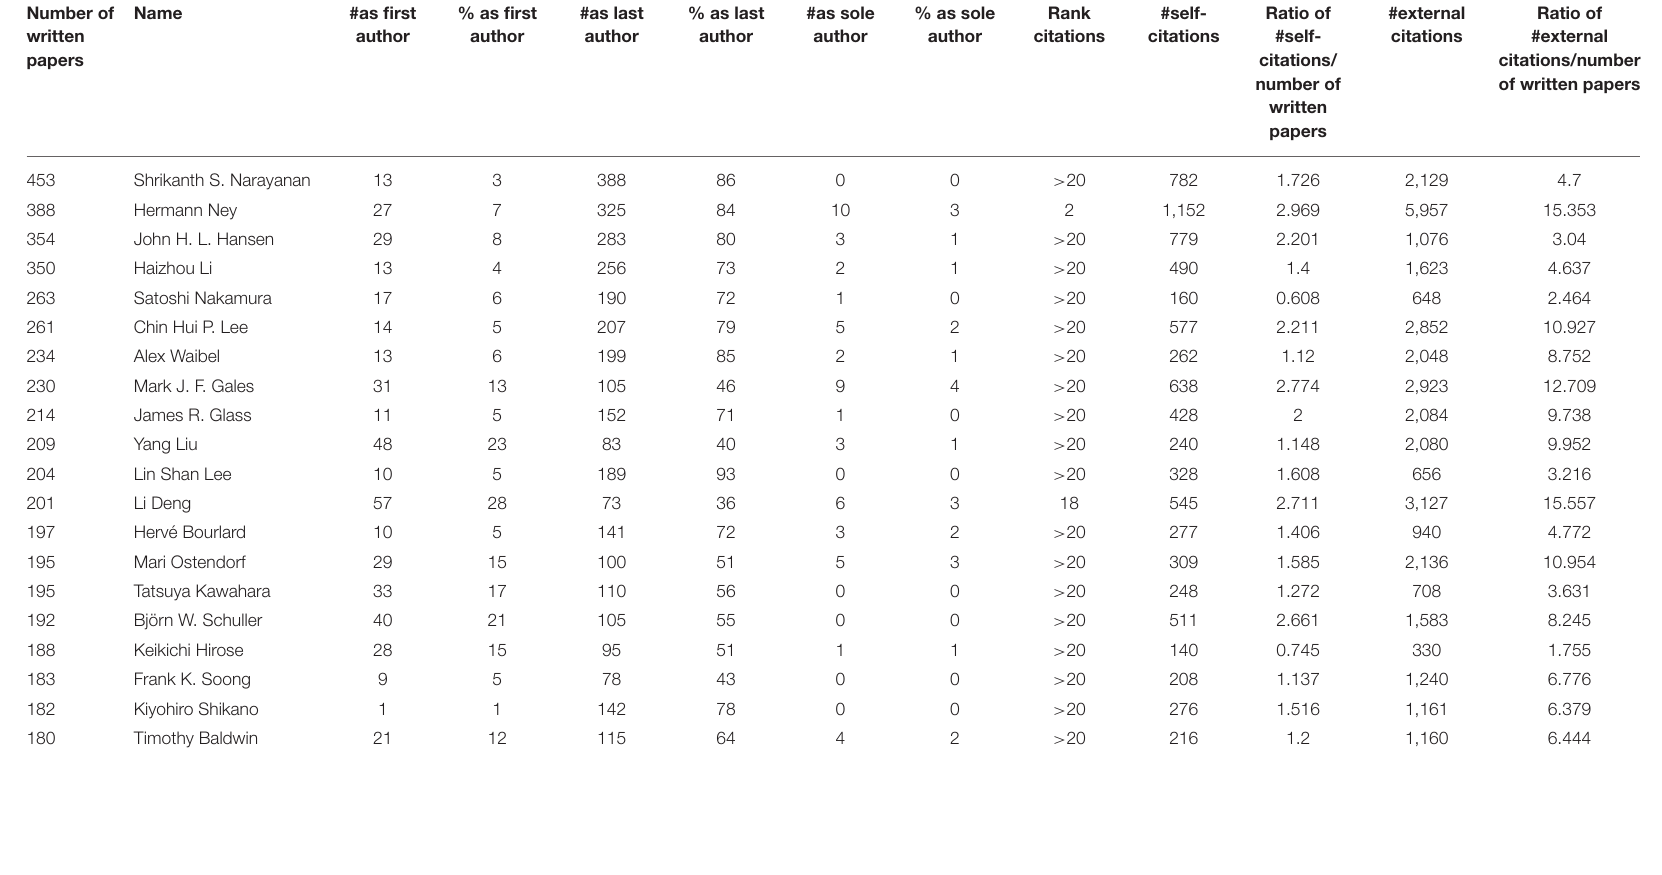
TABLE 14 | The number of citations for the 20 most productive authors